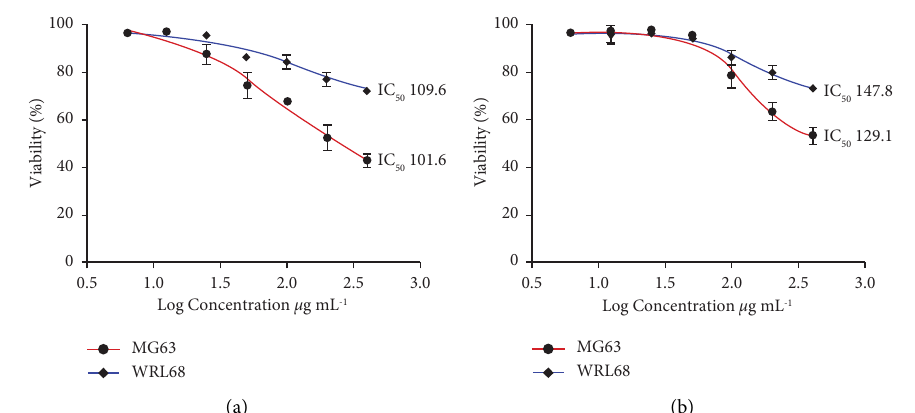
Figure 7: Cell survival curve (mean ± SD%) of MG63 and WRL68 after treatment with (a) HA and (b) Nd-Ce/HA for 24 hrs., with the details of cytotoxicity